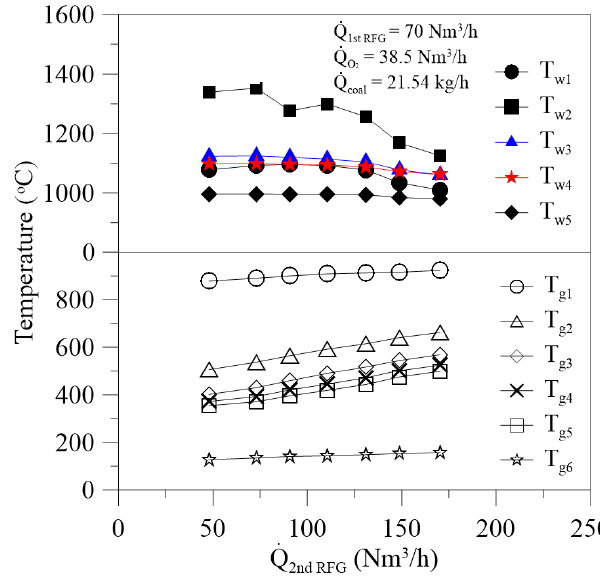
Figure 6. Variations of temperature with the 2nd RFG flow rate for Australian coal under oxy-combustion at Q O2 = 38.5 Nm 3 /h.